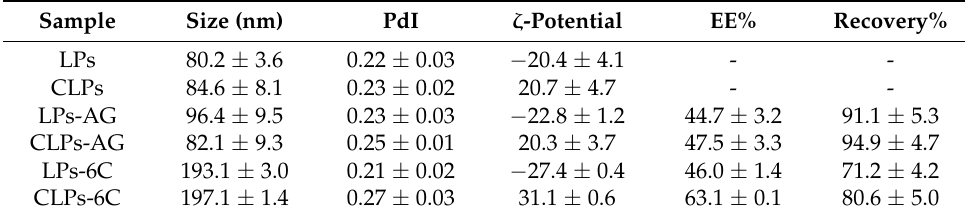
Table 1. Physical characterization of empty, andrographolide (AG) and coumarin-6 (6C) loaded liposomes. Sample